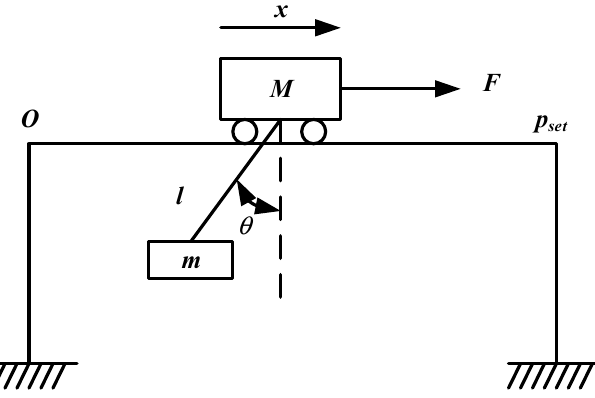
Figure 3. 2-D model of a bridge